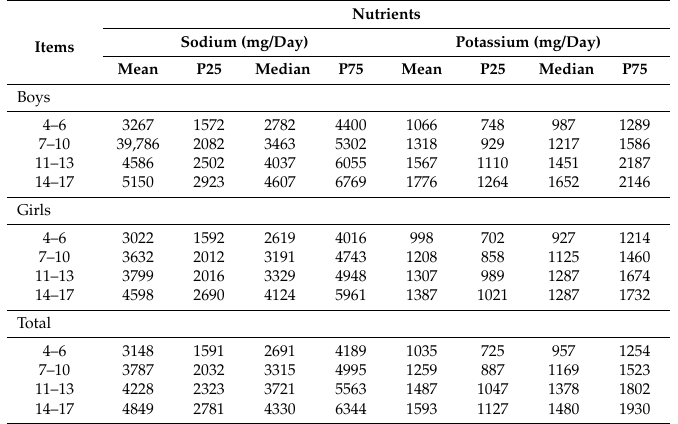
Table 3. Mean and selected percentiles of usual daily sodium and potassium intakes among Chinese children.